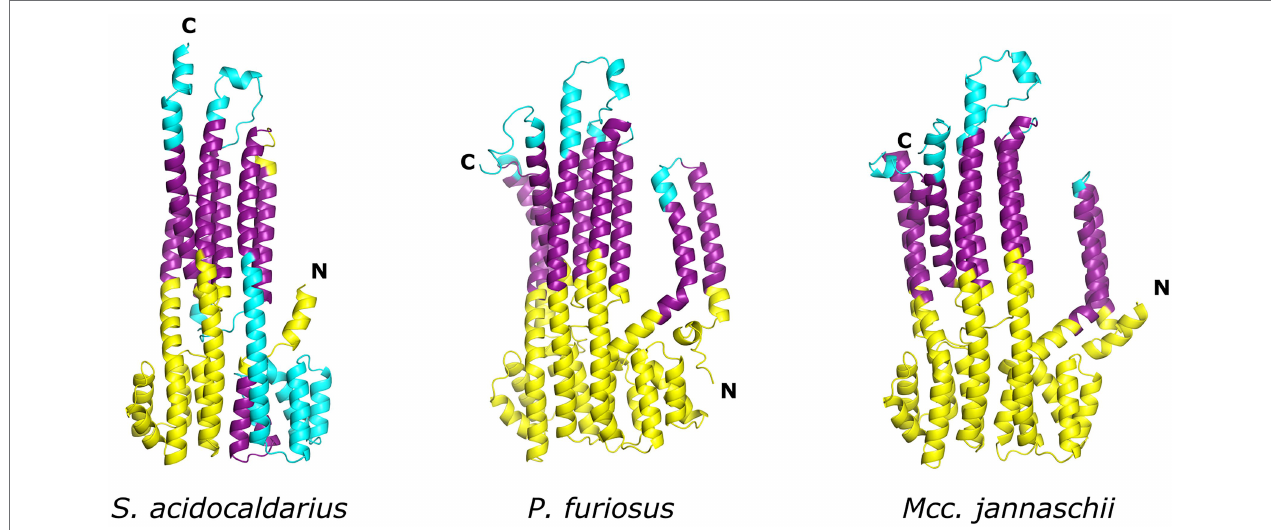
FIGURE 3 | Structure of ArlJ homologues predicted with AlphaFold. AlphaFold (Jumper et al., 2021) predictions of ArlJ from homologs of Sulfolobus acidocaldarius , Pyrococcus furiosus , and Methanocaldococcus jannaschii . Transmembrane regions were predicted with TMHMM. The cytosolic, transmembrane, and extracellular regions are, respectively, coloured yellow, purple, and